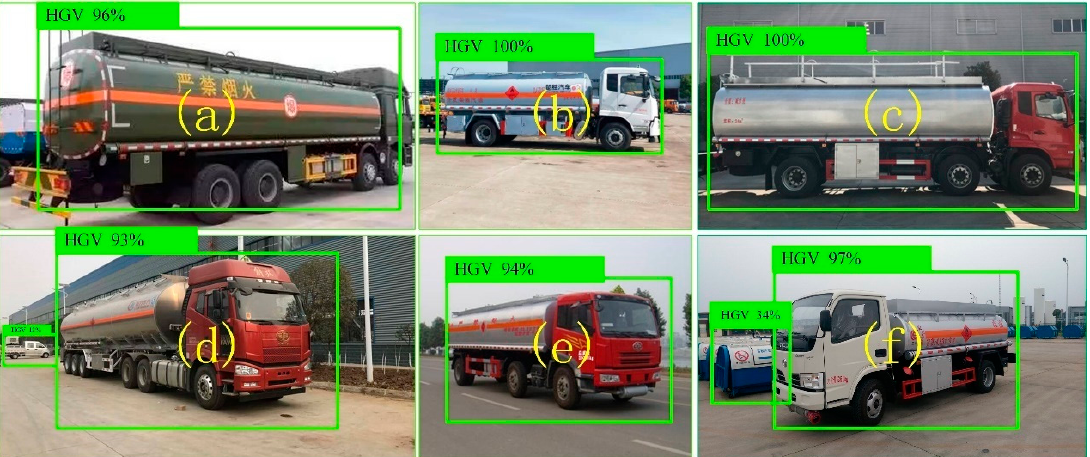
Figure 8. ( a – f ) Deep learning vehicle detection model for hazardous goods vehicle detection in different